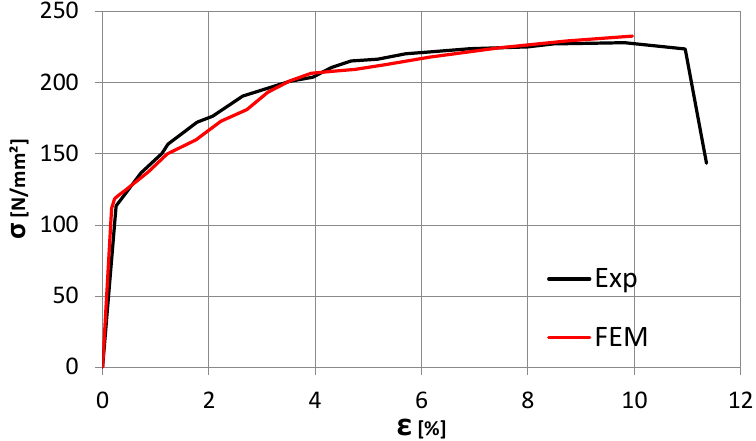
Figure 14. Comparison between the Experimental and Finite element analysis of the specimen. The two curves show a good similarity with a small discrepancy observed in the elastic range of the specimen behaviour.